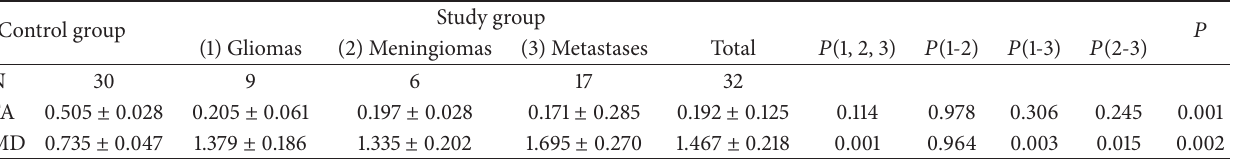
Table 2: FA and MD of GCT in the study group and the control group ( × 10 −3 mm 2 /s). Control